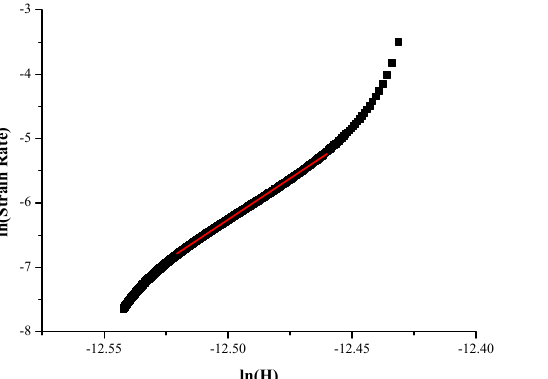
Figure 3. Linear fitting on steady creep area for extrapolated stress exponent (n) slope calculation. Appl. Mech. 2022 , 3 , FOR PEER REVIEW